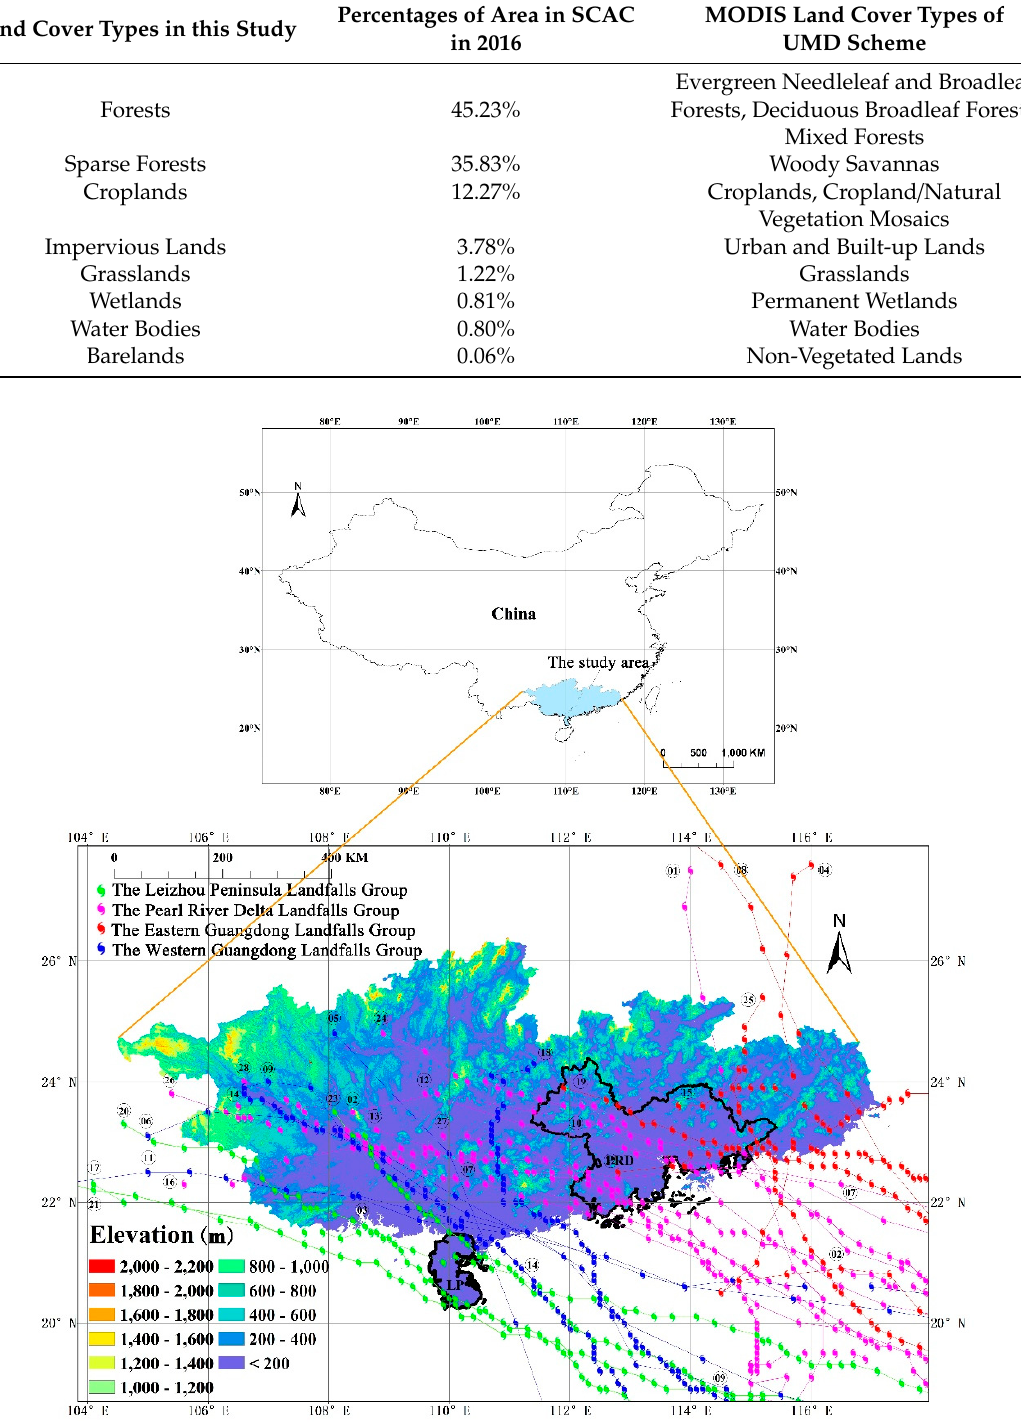
Figure 2. The study area and 28 typhoons of four landfall groups in the southeast coastal area of China (SCAC) from 2000 to 2018.